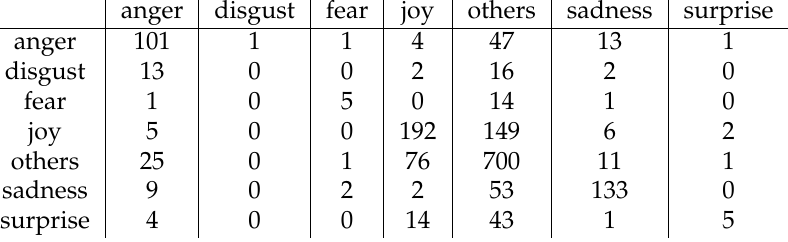
Figure 1. Confusion matrix over the test set for the best model. Rows show expected values and columns show predicted values.